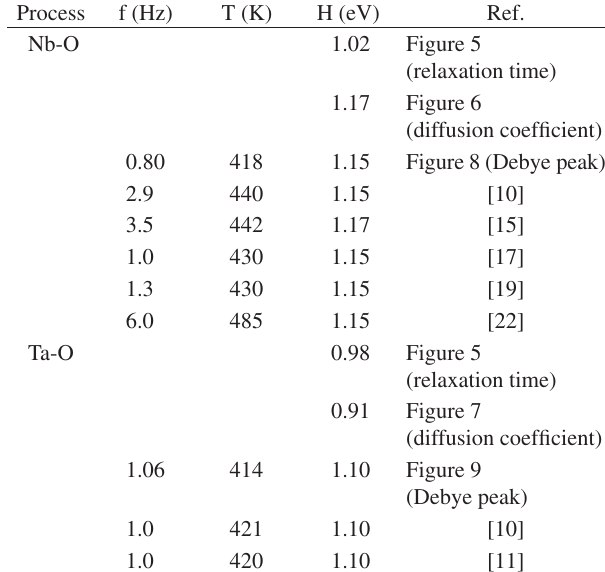
Table 2. Relaxation parameters for oxygen diffusion in Nb and Ta.